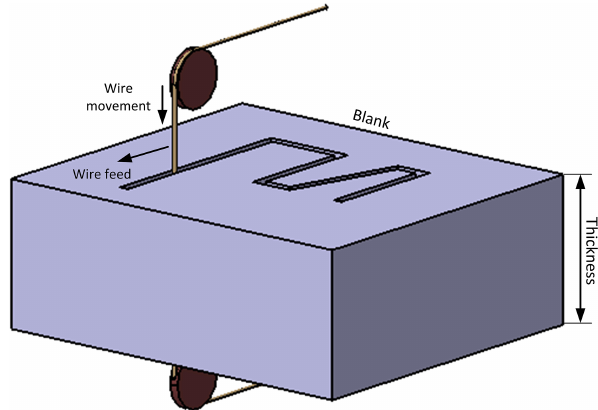
Figure 1. Illustration of Wire EDM